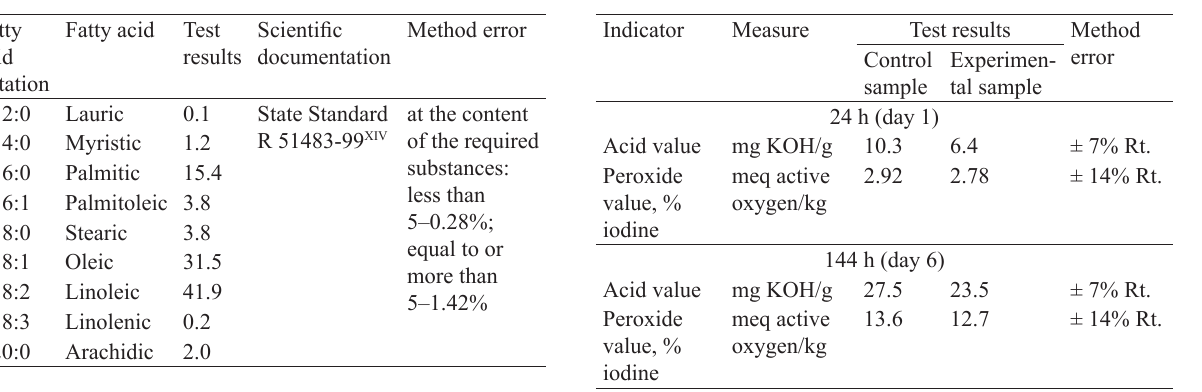
Table 13 Fatty acid composition of carp fat phase Table 14 Peroxide and acid values in carp during